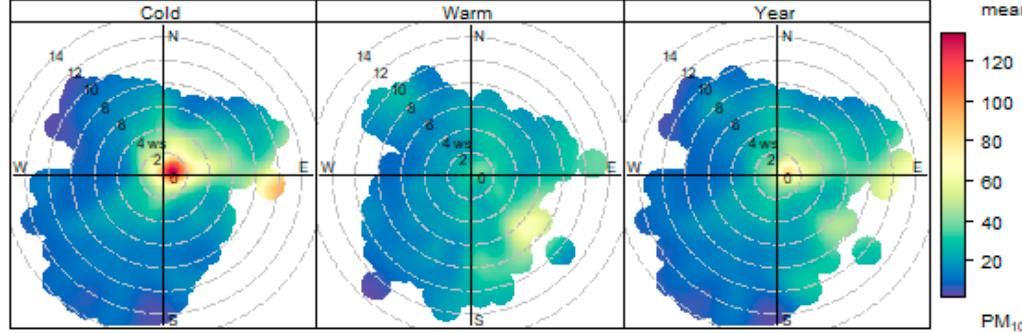
Figure 7. PM 10 weighted concentration rose (except for the wind speed parameter), the V ěřň ovice site, 2011–2020.